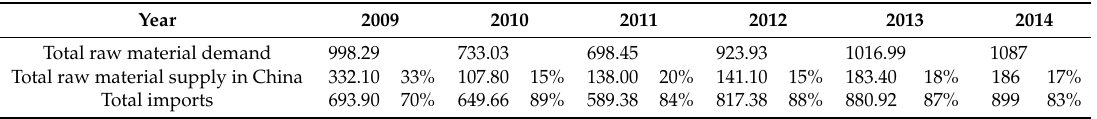
Table 1. Cassava supply and demand balance in China. ‘0000